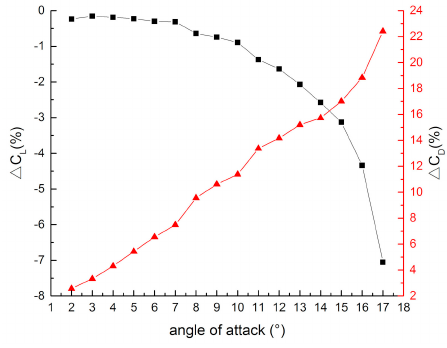
Figure 16. Lift and drag coefficient increments of NACA0012 at m = 1% and Re = 1 × 10 6 .